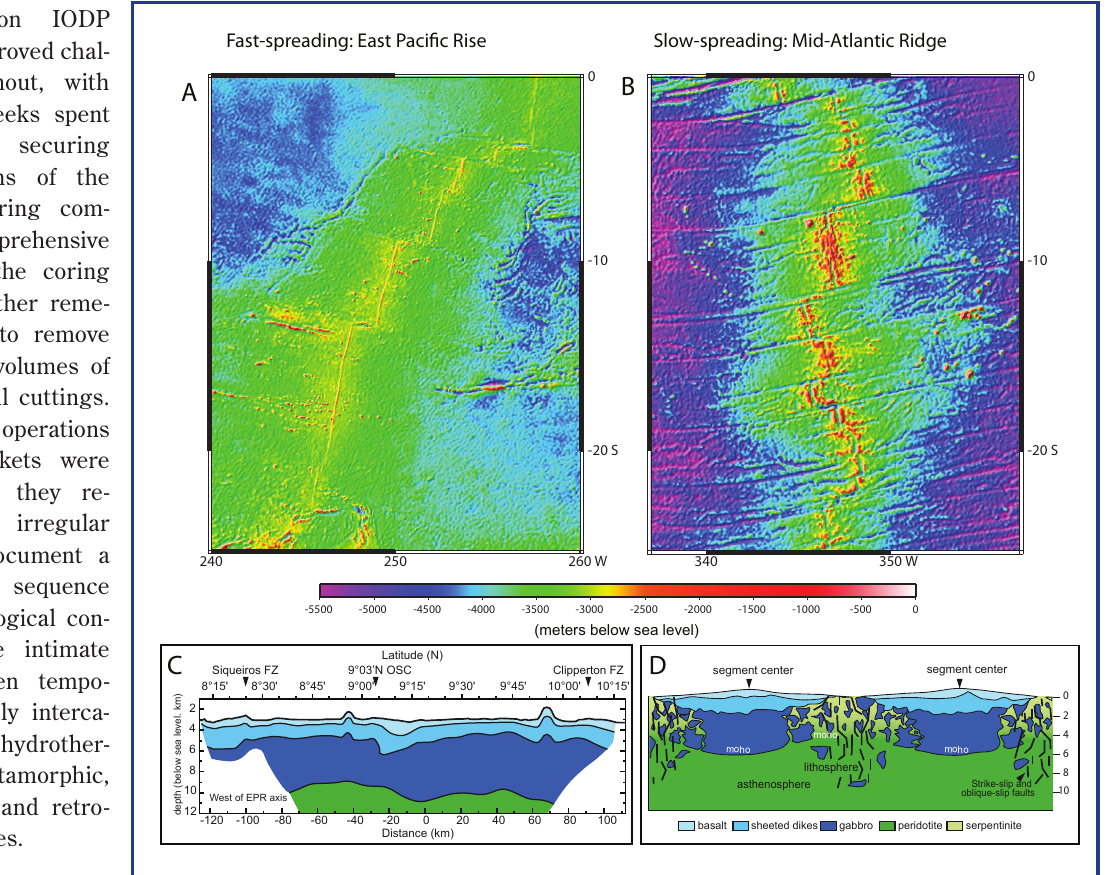
Figure 1. Bathymetric maps of the [A] fast spreading southern East Pacific Rise (EPR) compared to the [B] slow spreading Mid-Atlantic Ridge (MAR) from the equator to 25°S. Note the more pronounced bathymetric relief and axial graben along the MAR as well as the more closely spaced transform faults. Interpreted along-axis sections for the [C] EPR from ~8° to 10° N (after Canales et al., 2003) and [D] MAR (after Cannat et al.,